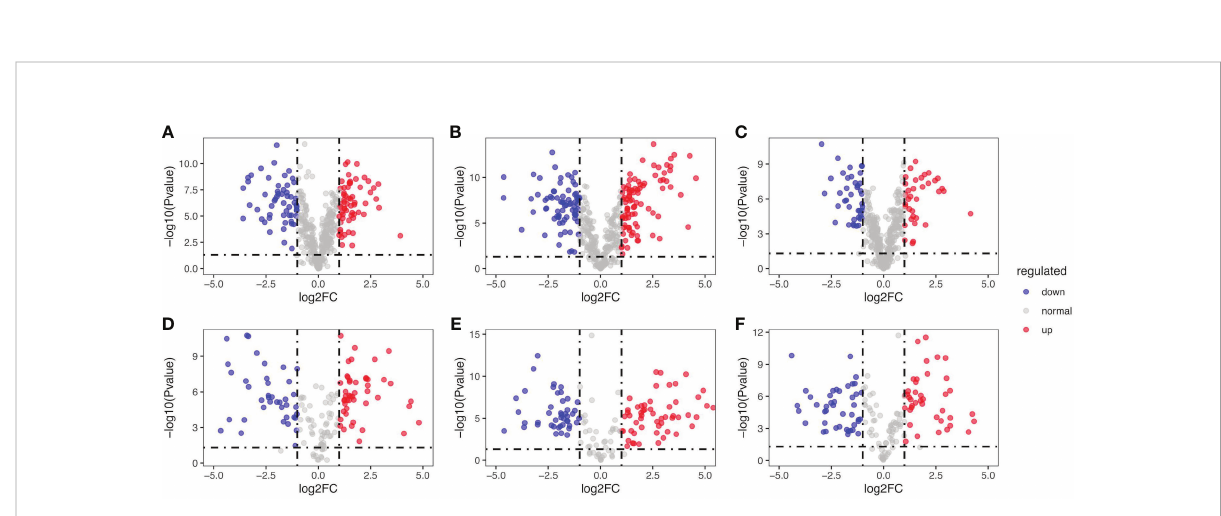
FIGURE 5 Transcriptome-based quantitative pro fi ling of CYPs and UGTs in the differential samples. Volcano plot of p -value (log2 scale) vs fold-change (FC, positive if DEGs are higher expressed in samples with higher ginsenosides accumulation). The red and green points denote upregulated DEGs and downregulated DEGs in samples with higher ginsenosides accumulation, respectively. The grey points denote genes with no signi fi cant difference in expression between samples with higher ginsenosides accumulation and samples with lower ginsenosides accumulation. Differential expression analysis of UGTs: (A) 3yr_R vs 3yr_L, (B) 2yr_L vs 2yr_S, (C) 2yr_LR vs 3yr_S. Differential expression analysis of CYPs: (D) 3yr_R vs 3yr_L, (E) 2yr_LR vs 3yr_S, (F) 2yr_LR vs